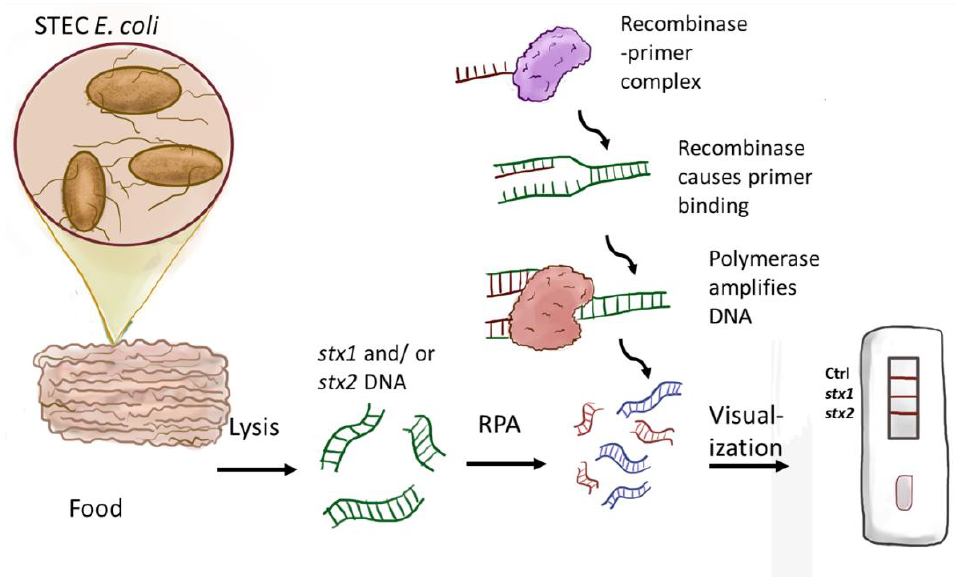
Figure 1. Schematic representation of the work performed in this study. Briefly, E. coli is lysed within a sample and then the stx DNA is amplified with RPA before being visualized on a lateral flow assay strip.